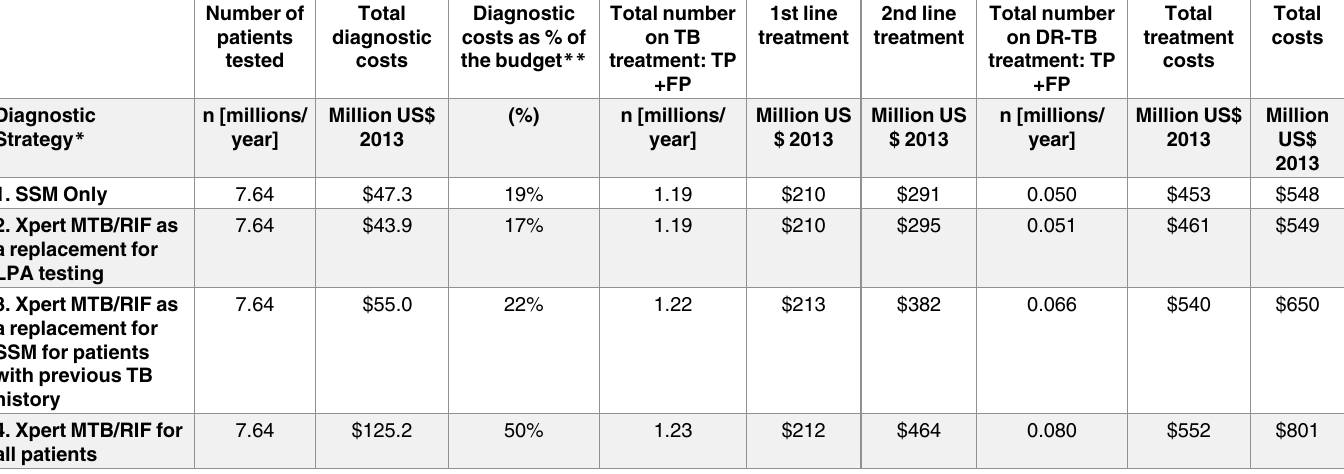
Table 5. Total diagnostic costs and treatment costs under the TB control program for 4 diagnostic